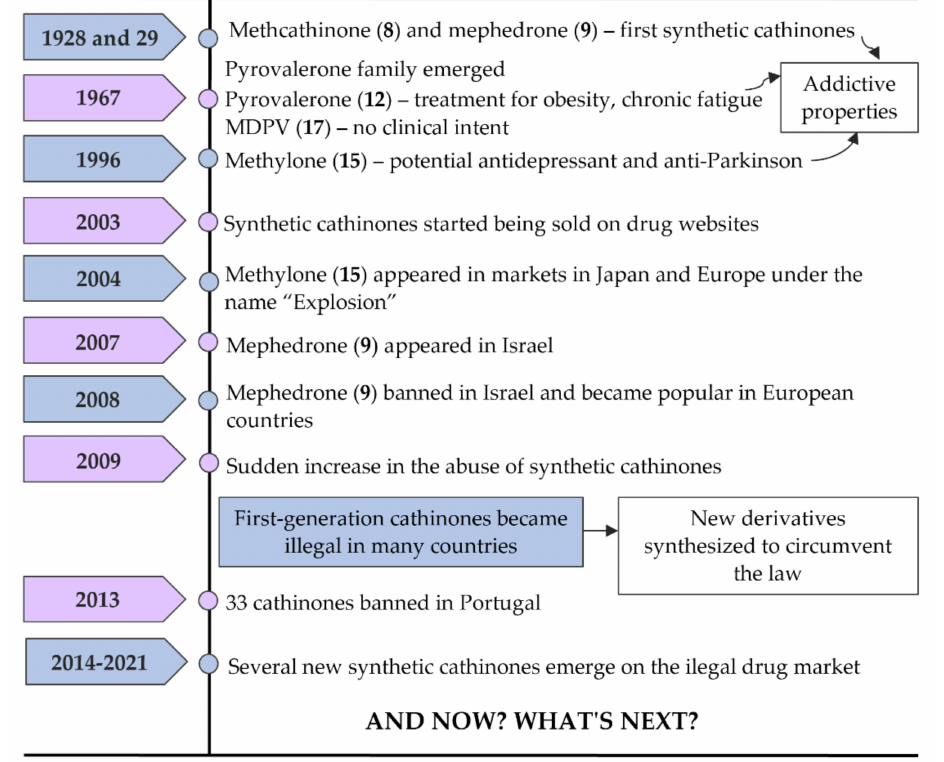
Figure 6. Timeline of events related to the history of synthetic cathinones. Methcathinone ( α -methylamino-propiophenone or ephedrone (EPH), ( 8 )) and